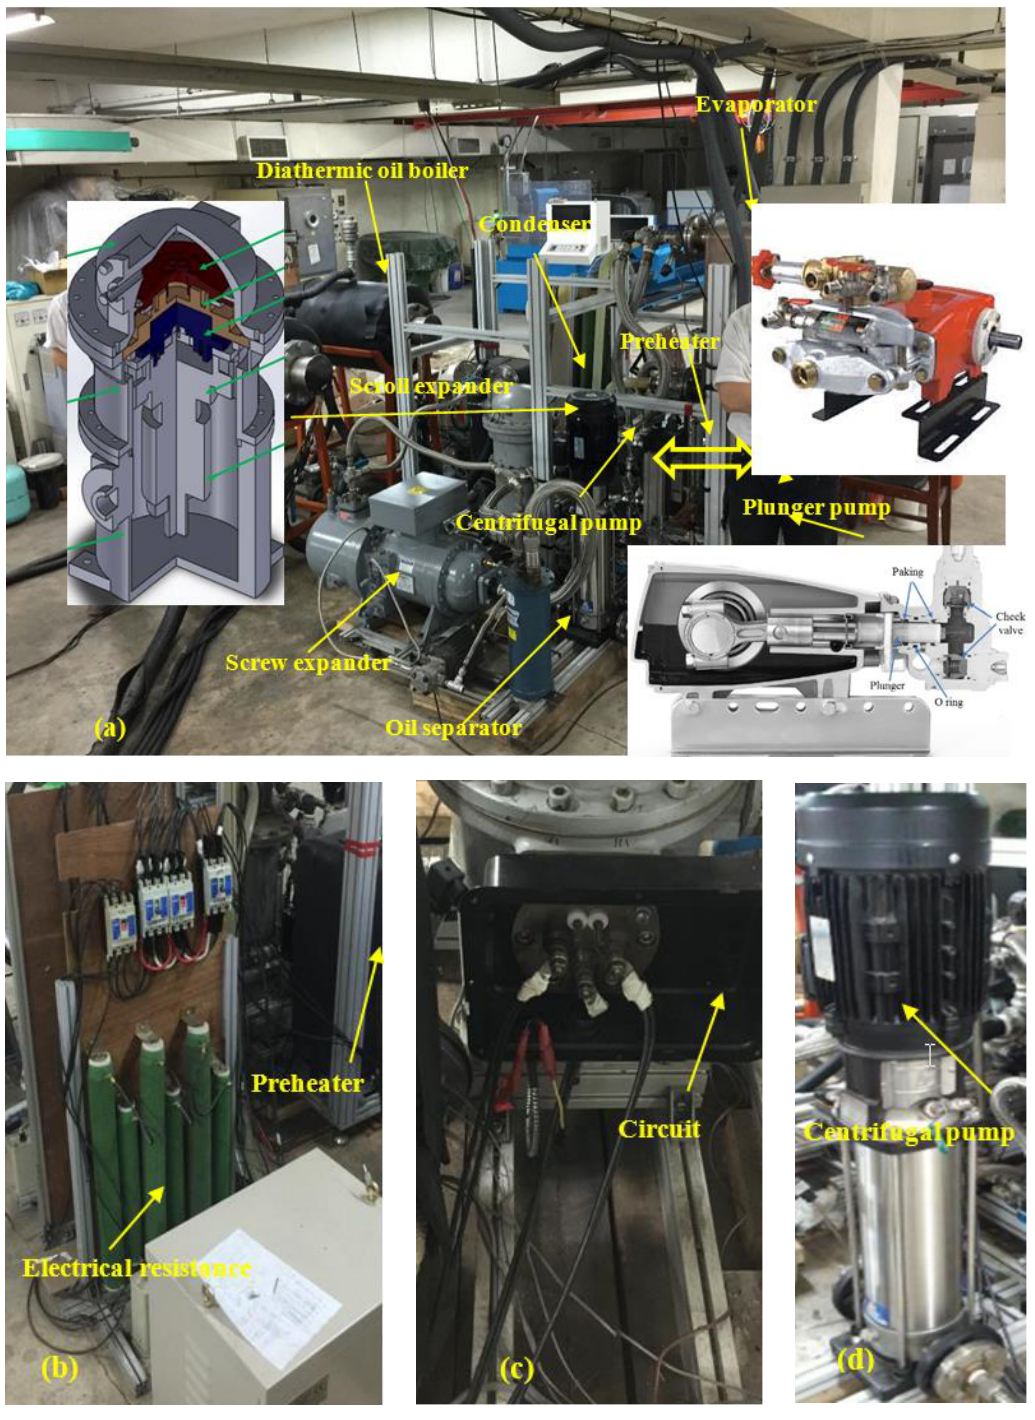
Figure 1. Schematic diagram of the experimental bench.